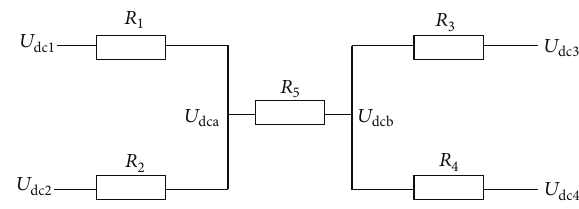
Figure 4: DC equivalent circuit of four-terminal MTDC